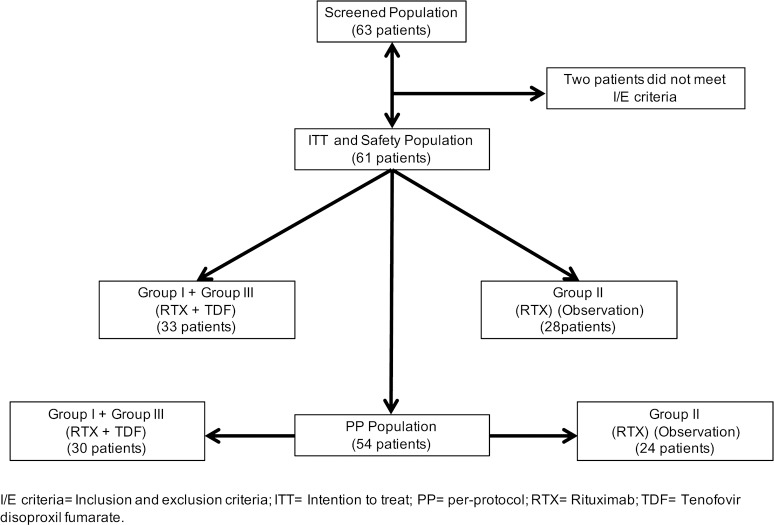
Study population.